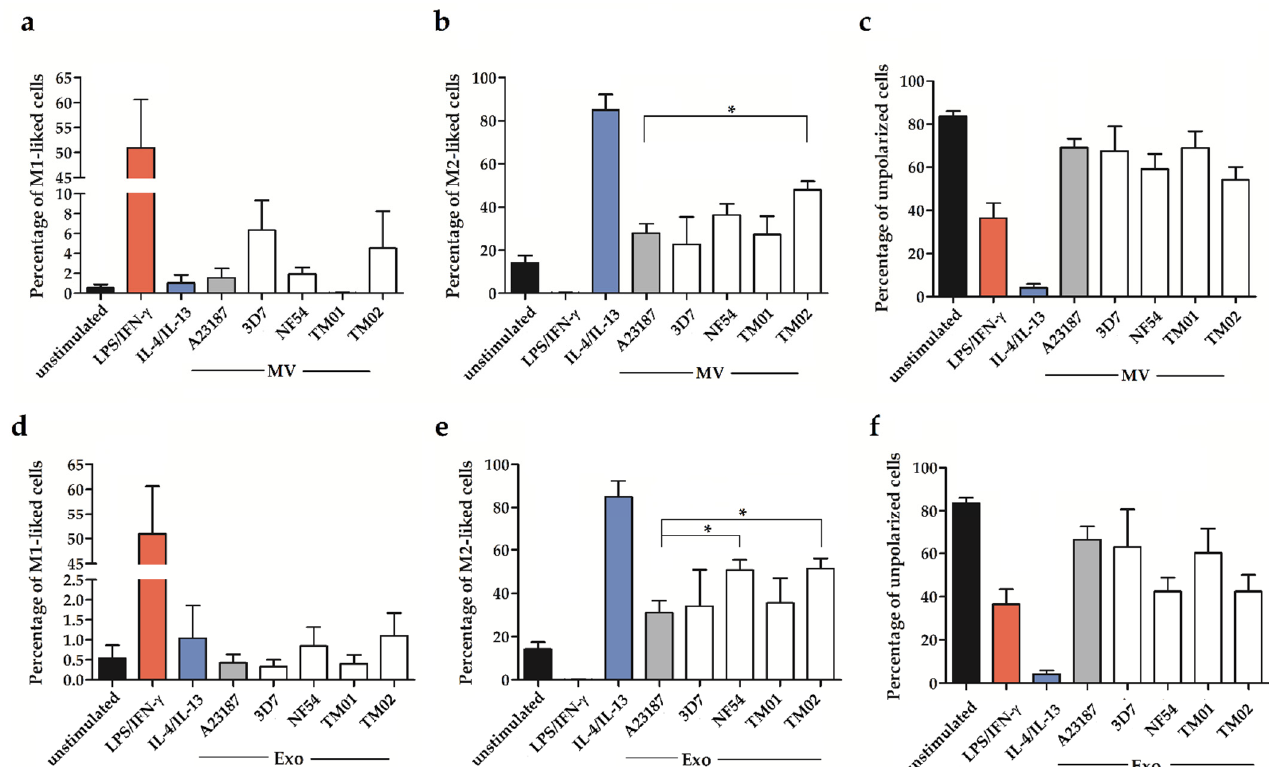
Figure 5. The monocyte polarization of the CD14 + CD16 + subpopulation after EV stimulation: MV stimulation (upper panel) and Exo stimulation (lower panel). The percentage of M1-like cells ( a , d ), M2-like cells ( b , e ), and unpolarized cells ( c , f ) among the CD14 + CD16 + subpopulation were shown. LPS/IFN- γ and IL4/IL13 were stimulators for M1-like and M2-like cells. The data showed as mean ± SEM from 4 independent experiments. * p < 0.05 between Pf -EV-stimulated cells and A23187-EV-stimulated cells.